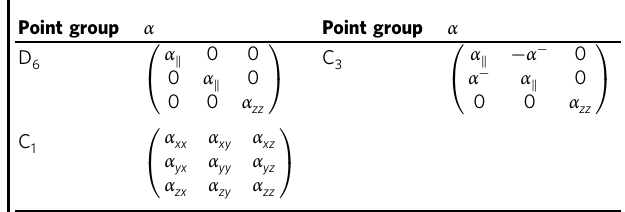
Table 1 Magnetoelectric susceptibility pseudotensor α for D , C , and C point 6 3 1